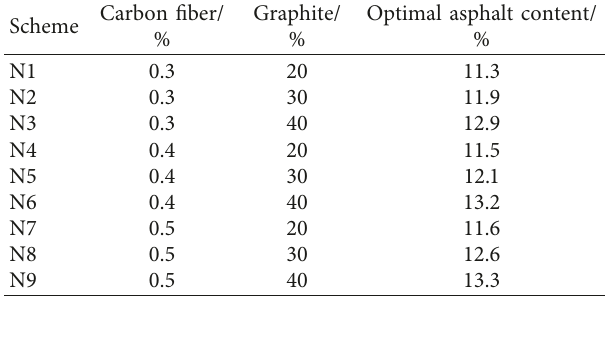
Table 5: Test scheme of cast conductive asphalt concrete. Carbon fiber/ Graphite/ Optimal asphalt Scheme %